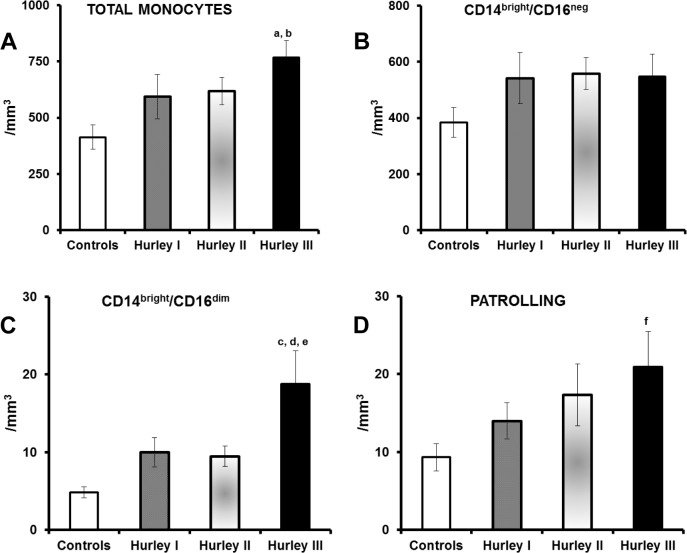
Monocyte subsets in HS.Absolute counts of (A) total circulating monocytes, (B) CD14bright/CD16neg monocytes, (C) CD14bright/CD16dim monocytes, and (D) patrolling monocytes are shown for healthy volunteers (n = 14), patients with Hurley I HS (n = 37), with Hurley II HS (n = 37) and with Hurley III HS (n = 44). P values of comparisons by ANOVA and post hoc Bonferroni corrections: a0.004 vs healthy controls; b0.026 vs Hurley I; c0.001 vs healthy controls; d0.012 vs Hurley I; e0.008 vs Hurley II; f0.037 vs healthy controls.